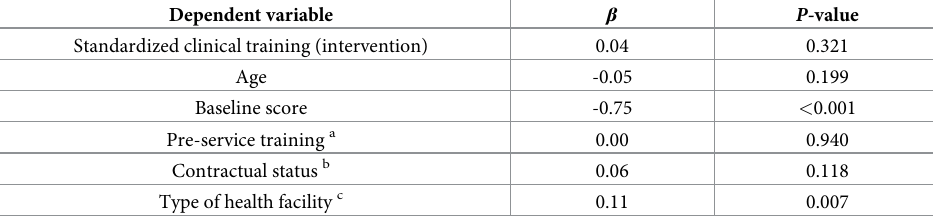
Table 5. Determinants of the mean increase in total competency